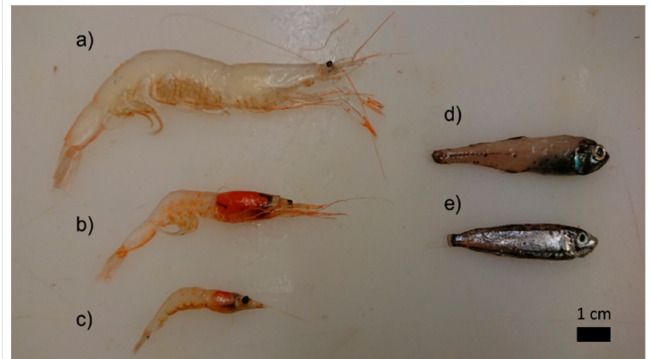
Figure 1. Mesopelagic species in Norwegian fjords. The shrimps ( a ) Pasiphaea sp. and ( b ) Eusergestes arcticus , the krill ( c ) Meganyctyphanes norvegica , and the fish species ( d ) Benthosema glaciale and ( e ) Maurolicus muelleri caught at a cruise in Osterfjorden, Bjørnafjorden and Boknafjorden on the Norwegian west coast in December